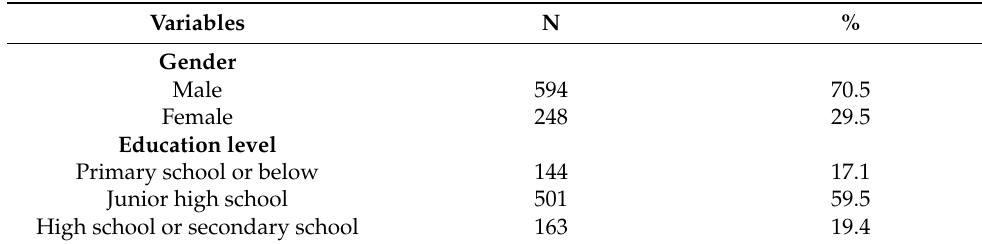
Table 1. Demographic characteristic of the participants (n =